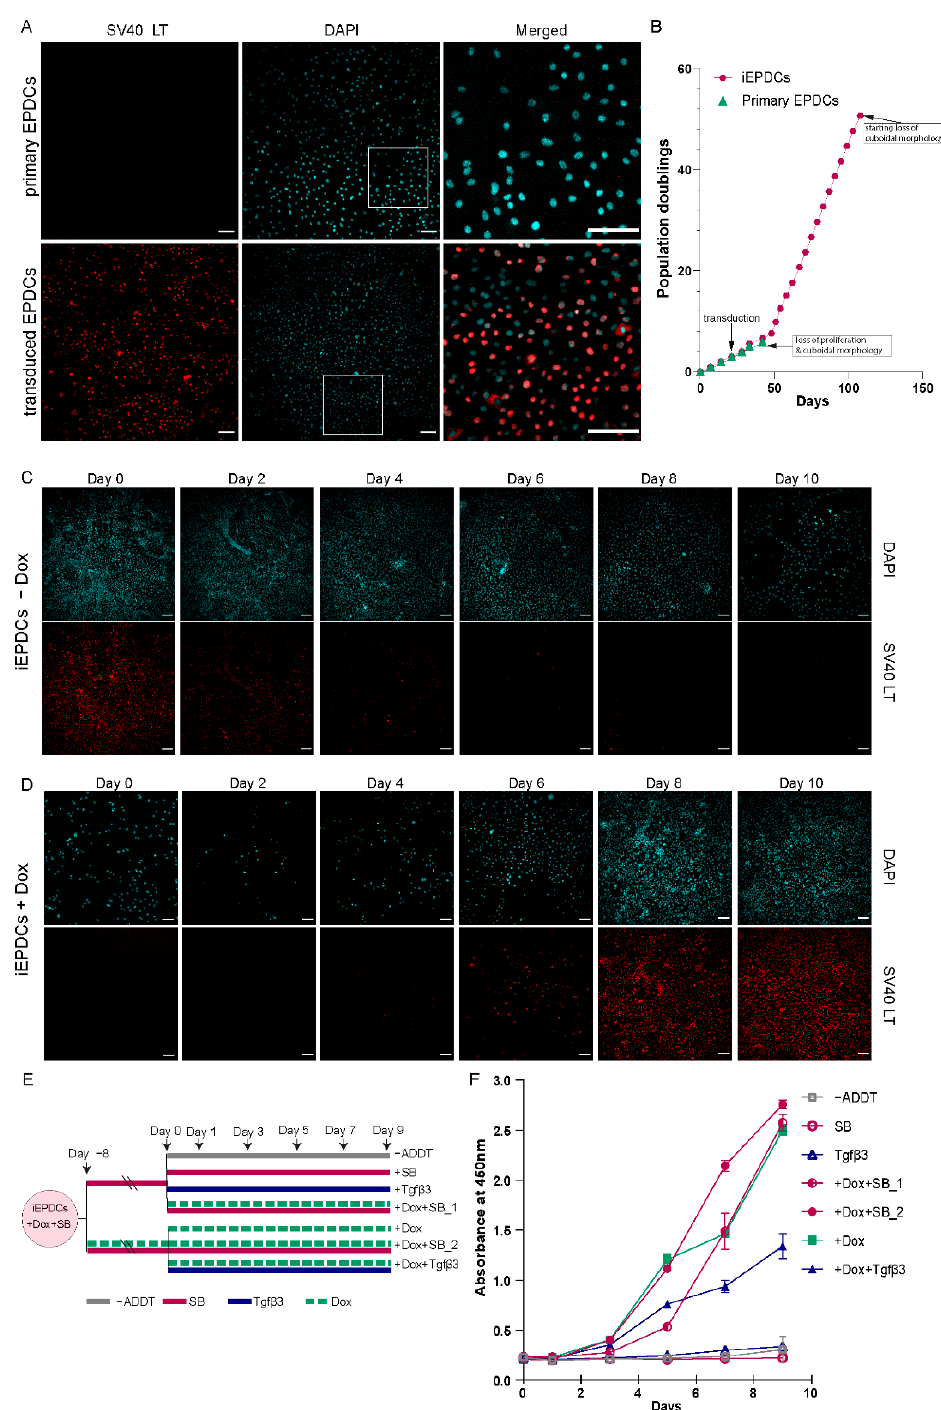
Figure 1. Generation of iEPDCs. ( A ) Confirmation of LT expression in iEPDCs (PD10) in the presence of Dox by immunofluorescent staining with anti-SV40 LT. ( B ) Growth curves of primary EPDCs and iEPDCs cultured in the presence of Dox. Recordings were ended when the EPDCs started to lose their cuboidal epithelial morphology. ( C , D ) Timeline of LT expression in iEPDCs after switching from Dox-containing to Dox-free culture medium ( C ) and vice versa ( D ). ( E ) Overview of the different pretreatments and culture conditions to which the iEPDCs were exposed for cell proliferation analysis. ( F ) Quantification of the proliferation of iEPDCs under the conditions indicated in ( E ). Scale bar = 100 µ m. − ADDT = no